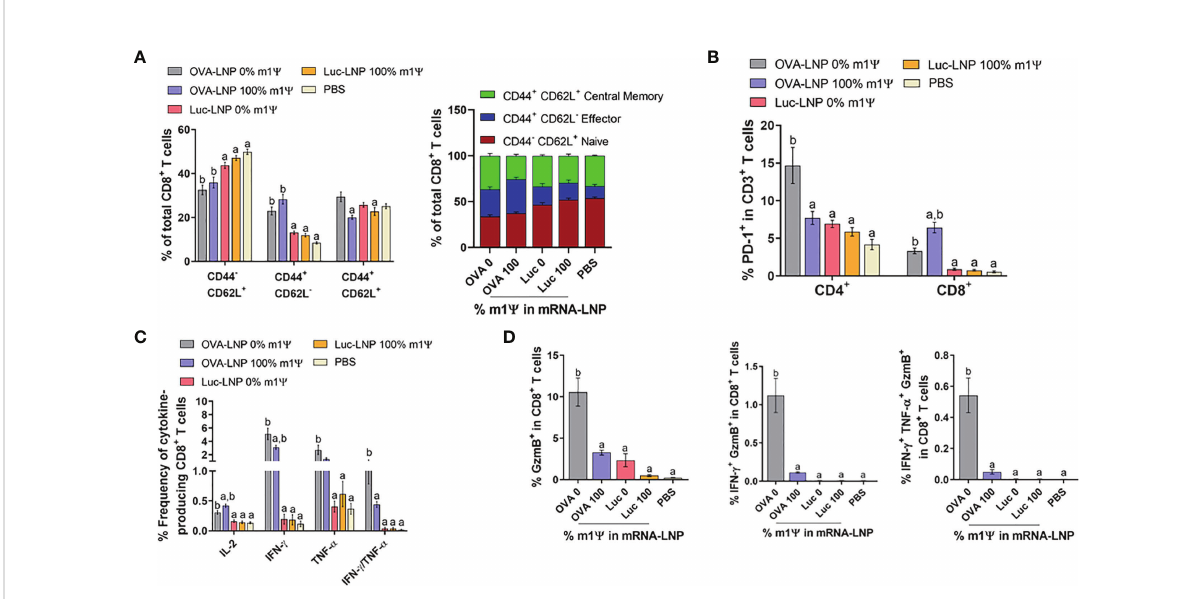
FIGURE 5 Immunization of unmodi fi ed OVA-LNP enhances the activation of antigen-speci fi c CD8+ T cells. Mice were treated as described in Figure 4A and the splenocytes were re-stimulated for 6 h with OVA 257-264 (SIINFEKL) peptide. (A) The frequencies of naïve cells (CD44 - CD62L + ), effector cells (CD44 + CD62L - ), and memory cells (CD44 + CD62L + ) in CD3 + CD8 + T cell subsets (B) the frequencies of PD-1+ CD4 + and CD8 + T cells and (C) the frequencies of cytokines-producing CD8 + T cells are shown. (D) The OVA 257-264 -specifc responses were determined and the percentages of CD8 + T cells producing GzmB, IFN- g /GzmB, or IFN- g /TNF- a /GzmB are shown. The results are presented as the mean ± SEM of biologically independent mice (n=7) per group. Statistical signi fi cance by one-way ANOVA with Bonferroni multiple comparisons test when p < 0.05 compared to the unmodi fi ed target antigen: a, control (PBS):